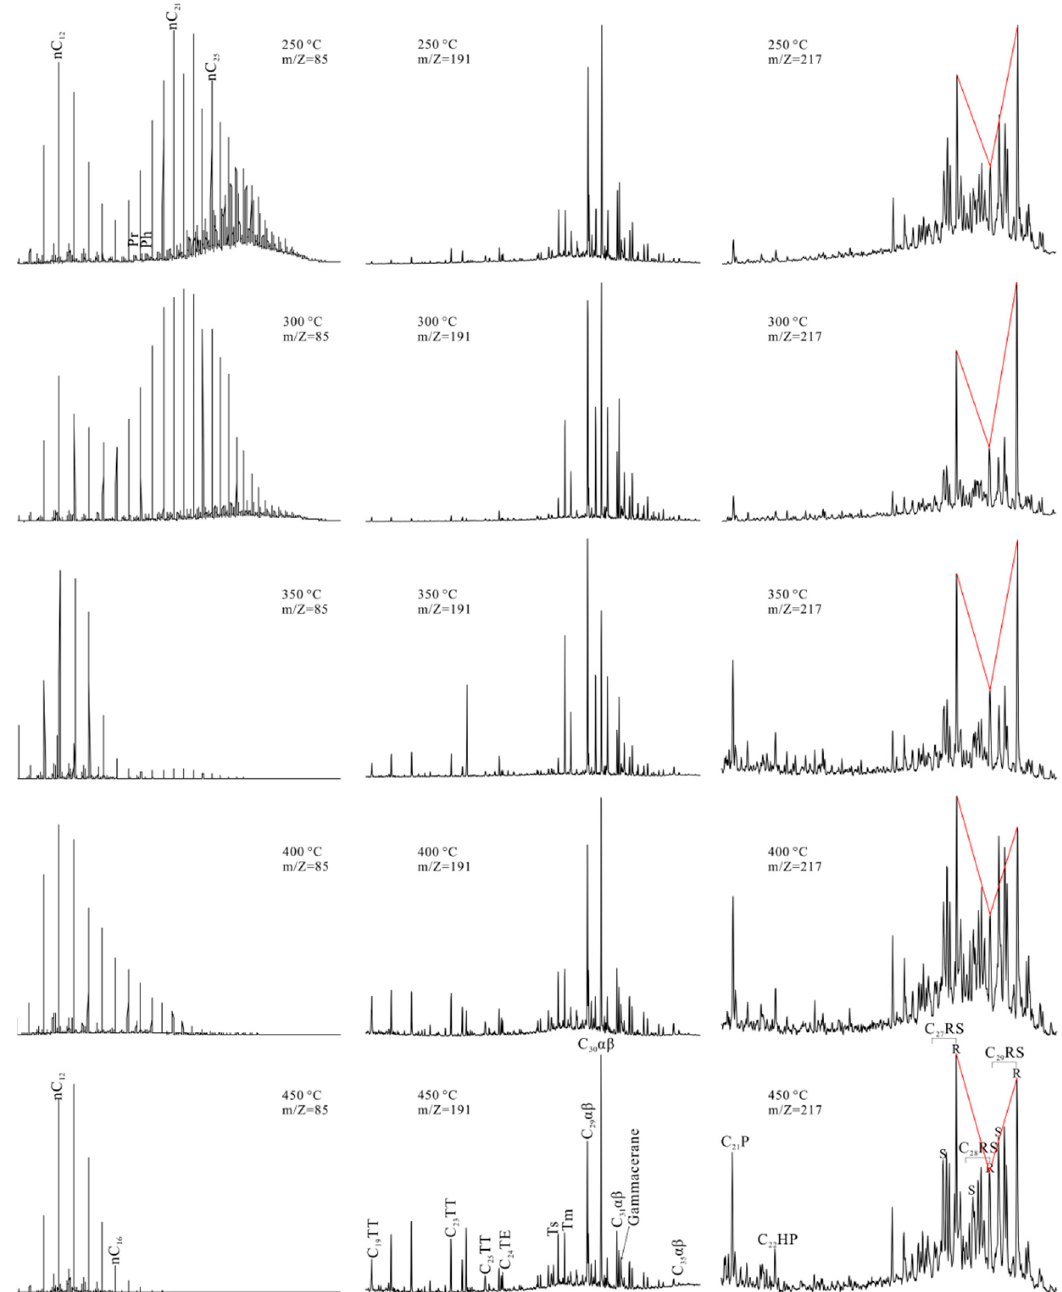
Figure 4. The biomarker characteristics of different simulation-experiment temperatures. Table 3. Composition characteristics of biomarkers in simulated experimental